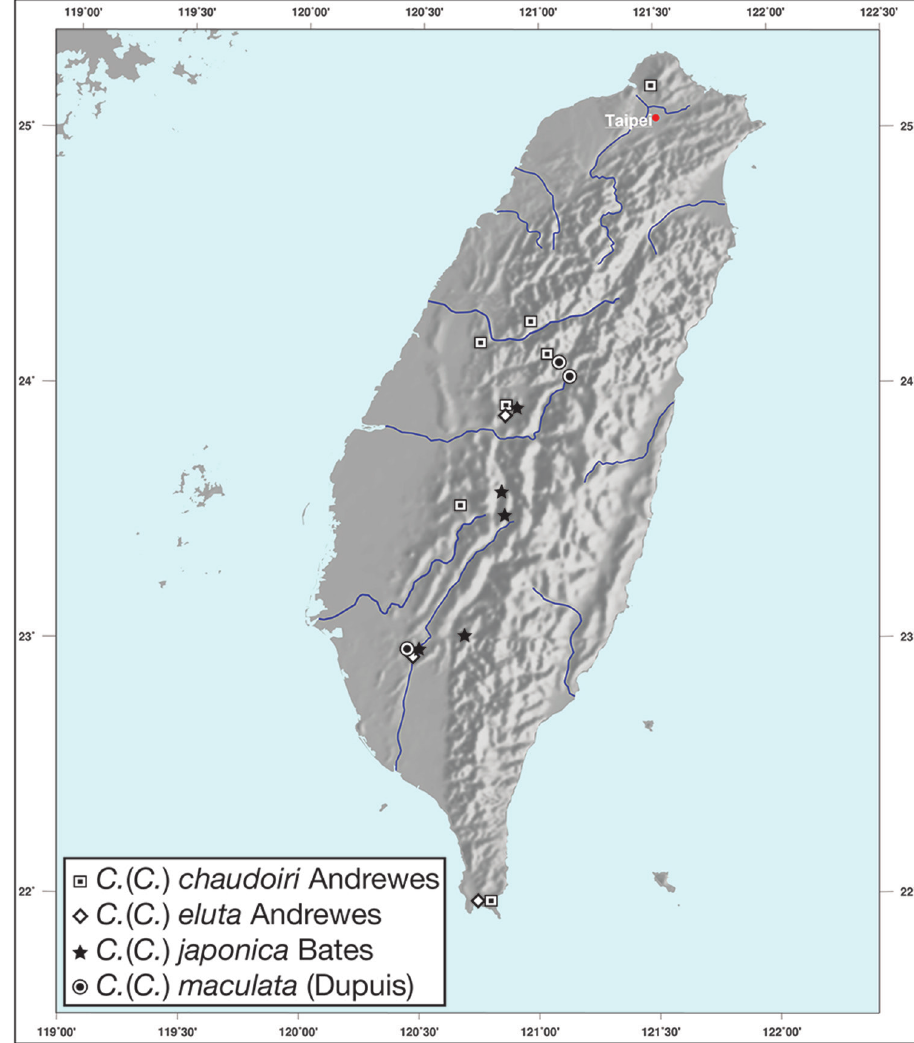
Figure 59. Map showing known localities for species of the genus Coptodera Dejean, subgenus Coptode- rina Jeannel, in Taiwan (in